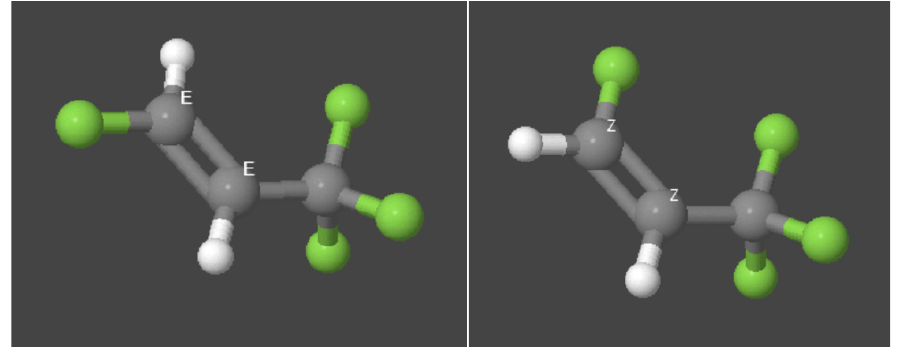
Figure 4. Drawing of the molecular structure of the two isomers of R1234ze; R1234ze(E) ( left ) and R1234ze(Z) ( right ). Table 3. Characteristics of HFOs R1234yf, R1234ze(E) and R1234ze(Z).